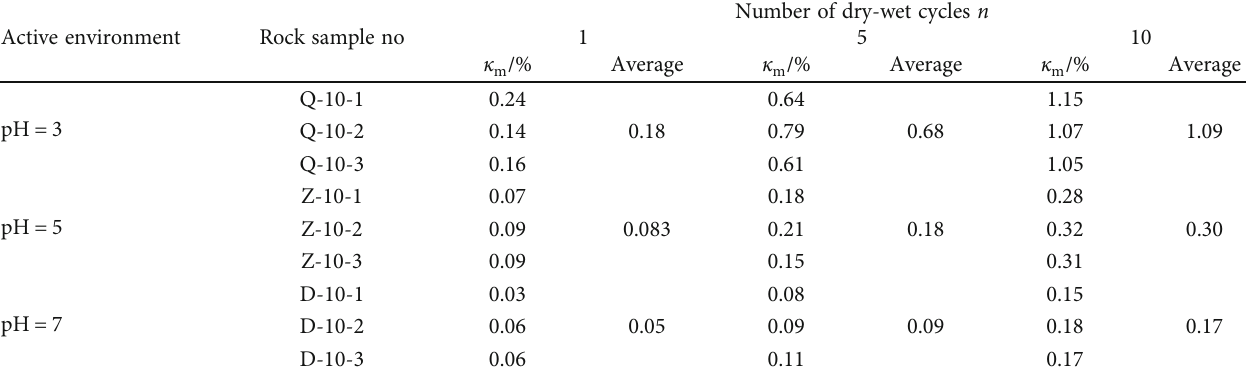
Table 5: The changing conditions of the limestone mass loss rate after di ff erent numbers of dry-wet cycles in di ff erent environments. Active environment Rock sample